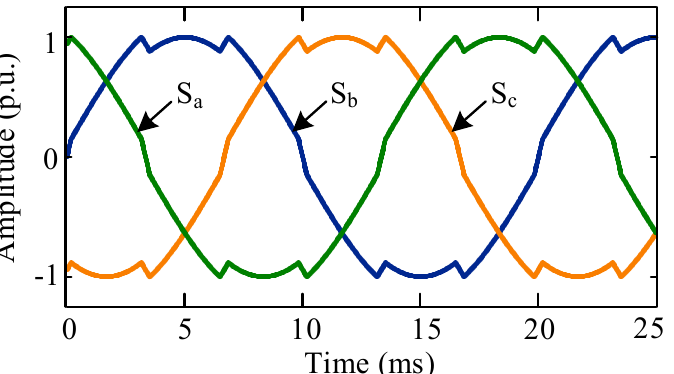
Figure 5. Proposed triangle saturated common mode pulse width modulation (TSCMPWM) modulating signal.